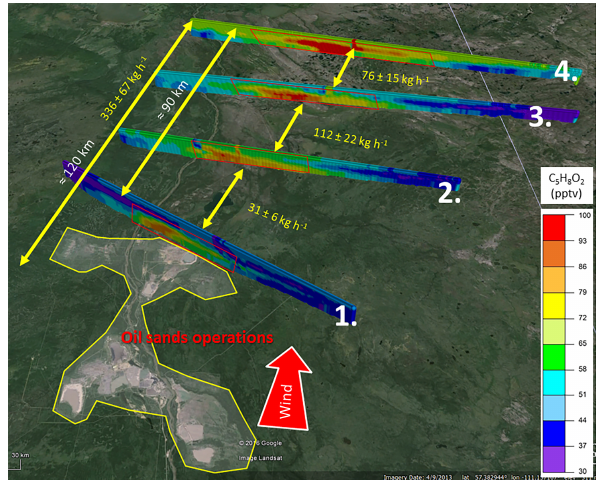
Figure 6. TERRA-derived concentration screens for F19 using C 5 H 8 O 2 as a relevant LMWOA example. The LMWOA transfer rate difference between screens represents the secondary produc- tion rate of a given species (yellow text, 219 ± 43kgh − 1 for screens 1–4). The overall rate from the oil sands source region is the inte- grated LMWOA transfer rate through screen 4 after subtracting a small primary emission rate (336 ± 67kgh − 1 ; see